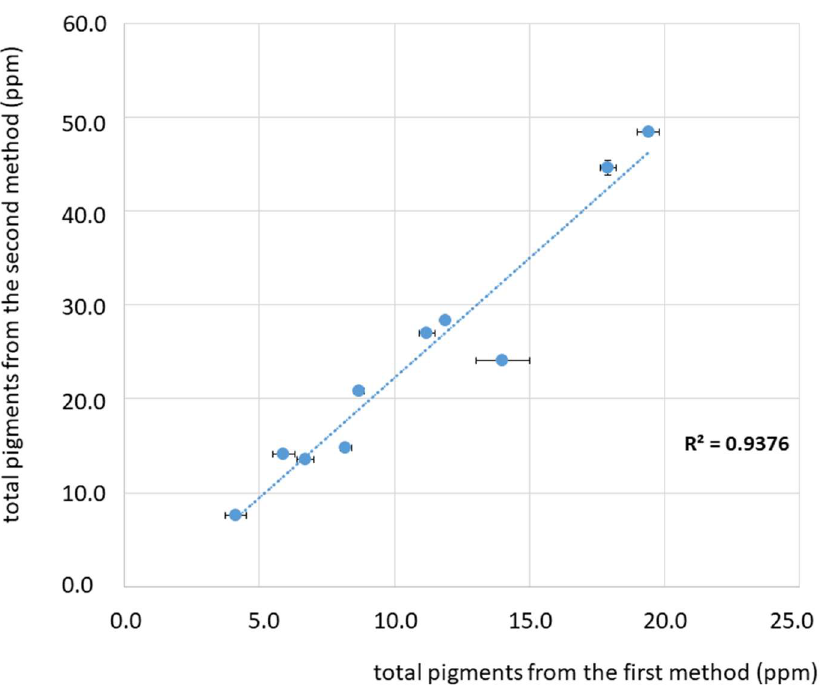
Figure 5. Plot of the sum of pigments (ppm) for the investigated olive oil samples as obtained from the two spectroscopic methods: Values obtained with the method proposed by Mínguez-Mosquera et al. [11] on the abscissa and by Domenici et al. [17] on the ordinate. A linear curve is shown, which correlates the two values, as described in the text. Each data point is displayed with an error bar corresponding to the confidence interval (CI). The R 2 value corresponding to the linear regression fit is also reported.